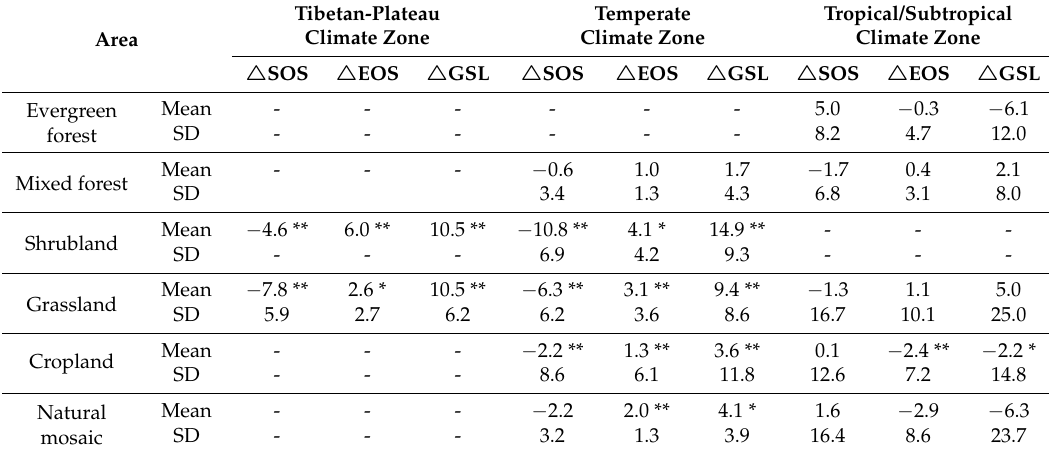
Grassland Cropland Natural mosaic